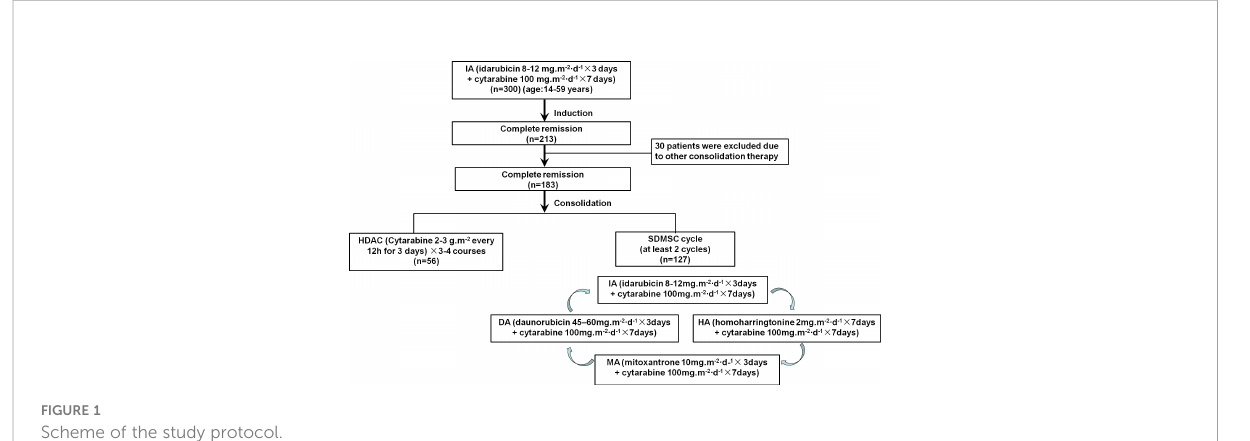
FIGURE 1 Scheme of the study